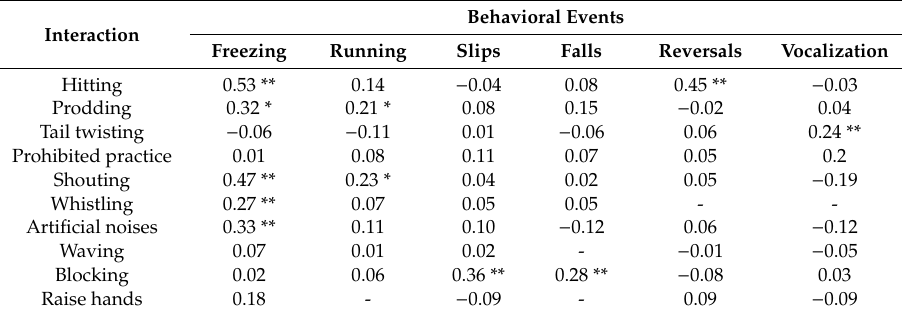
Table 4. Pearson correlation coe ffi cients (r) between the interactions of the handlers (per min) and behavioral events (per min) of cattle during handling at livestock market. Statistically significant correlations are presented in